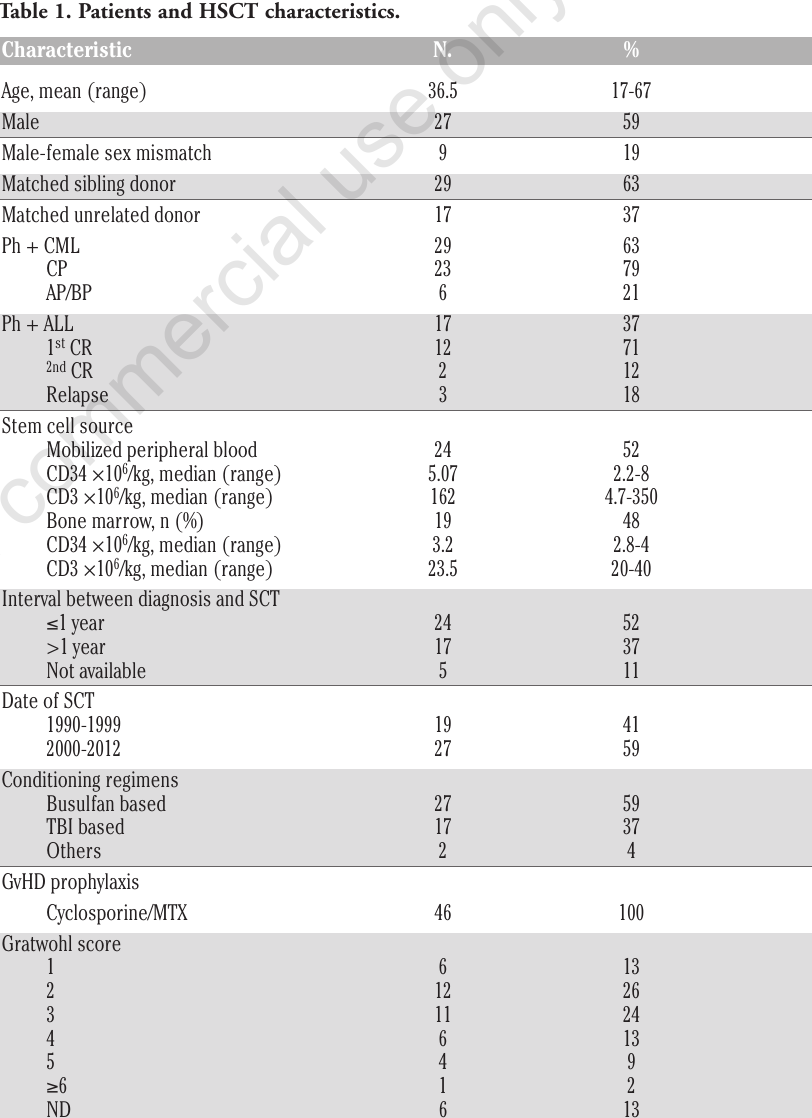
Table 1. Patients and HSCT